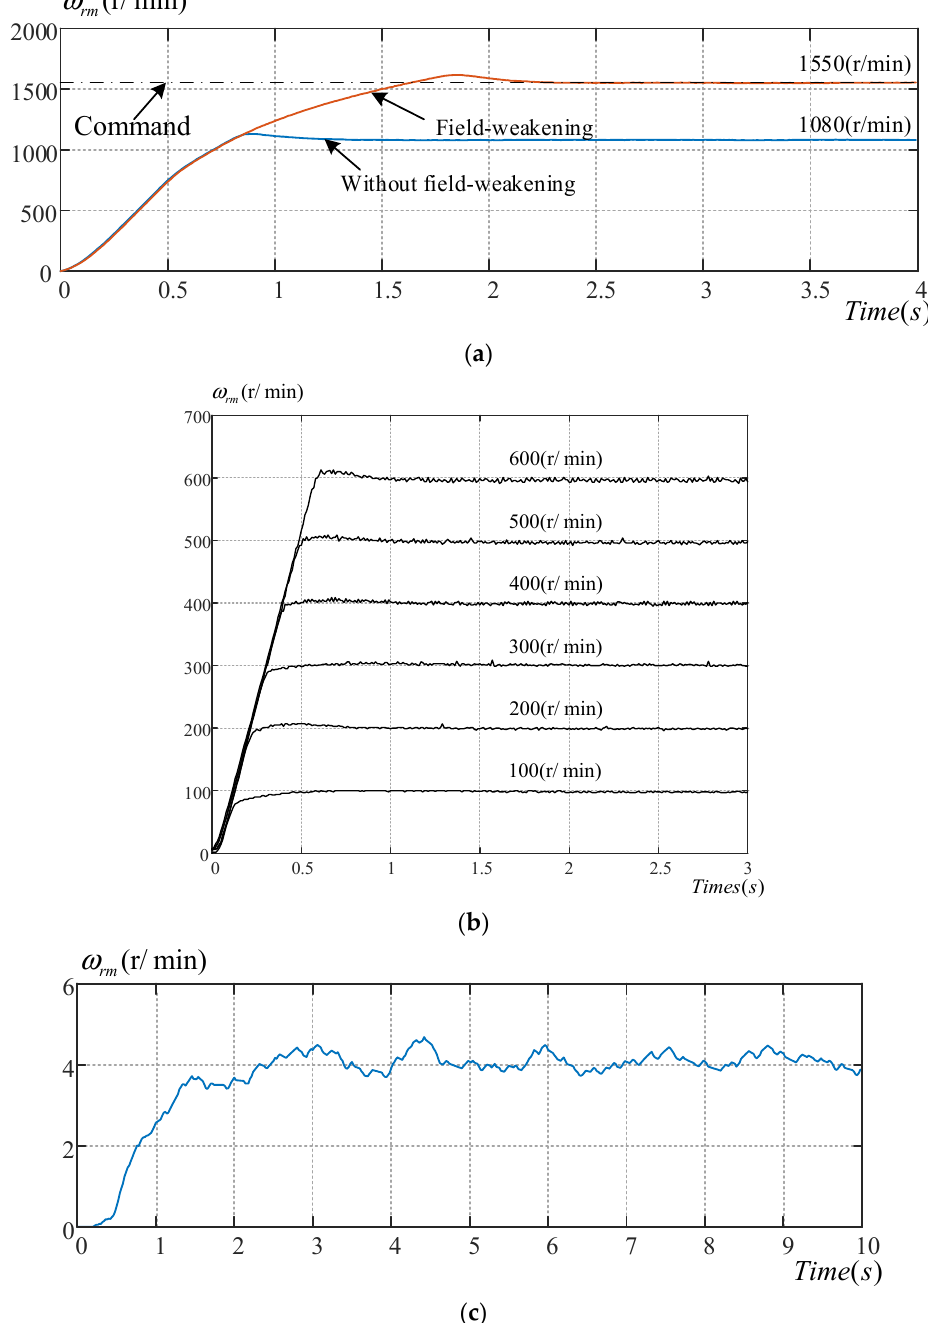
Figure 17. Measured highest, middle, and lowest operational speeds. ( a ) Highest speed, ( b ) middle